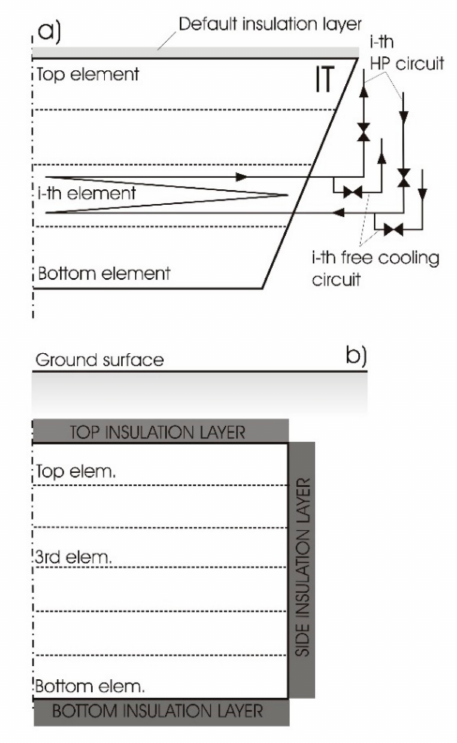
Figure 3. Ice tank (IT) schemes: ( a ) general; ( b ) case